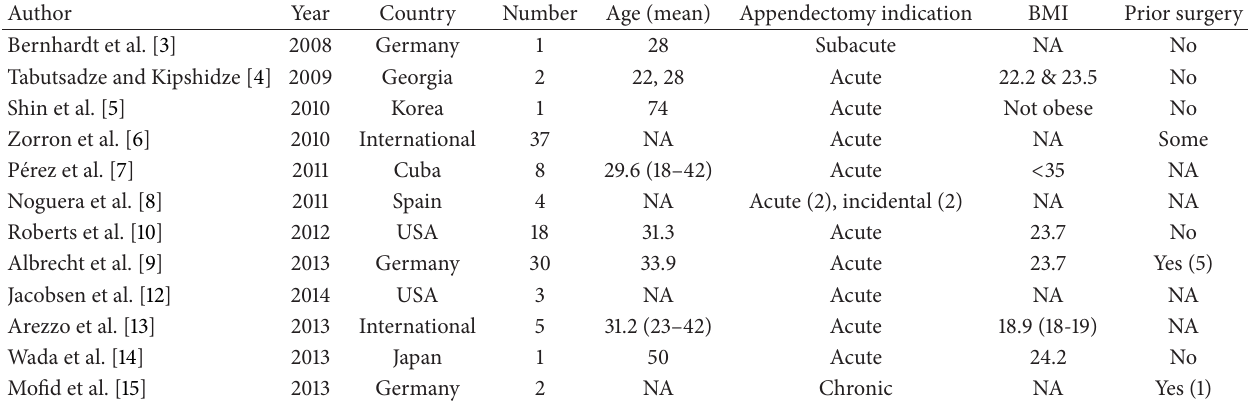
Table 2: Patient and article details.